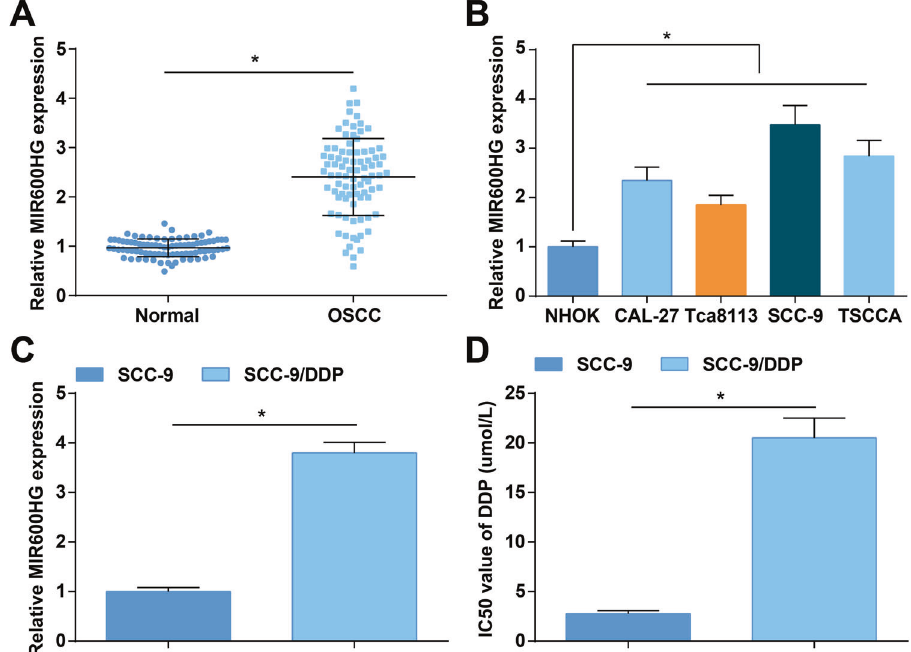
Fig. 1 MIR600HG is upregulated in OSCC tissues, cells, and DDP-resistant cells. A MIR600HG expression in clinical samples was assessed using RT-qPCR ( n = 85); B MIR600HG expression in NHOK and OSCC cell lines was assessed using RT-qPCR; C MIR600HG expression in SCC-9 and SCC-9/DDP cells was assessed using RT-qPCR; D IC 50 of SCC-9 and SCC-9/DDP cells was detected using MTT assay; N = 3; * P < 0.05; the results were exhibited as mean ± standard deviation; t -test or ANOVA was used to analyze